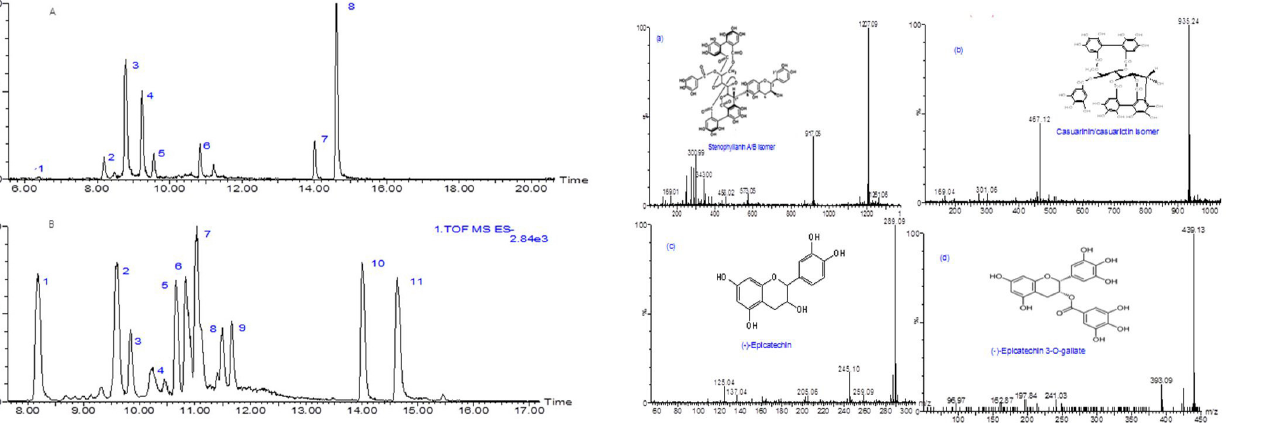
FIGURE 2 - UPLC-TOF-ESI-MS peak chromatograms of leaves (Figure 2A.) and stem bark (Figure 2B), MS in negative ion mode, UV at 280 nm, for the methanol extract from Anisophyllea laurina.